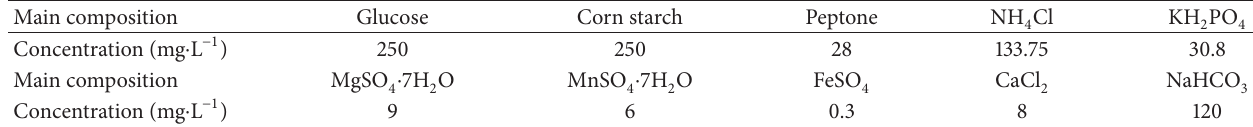
Table 1: The main constituent of the synthetic wastewater.